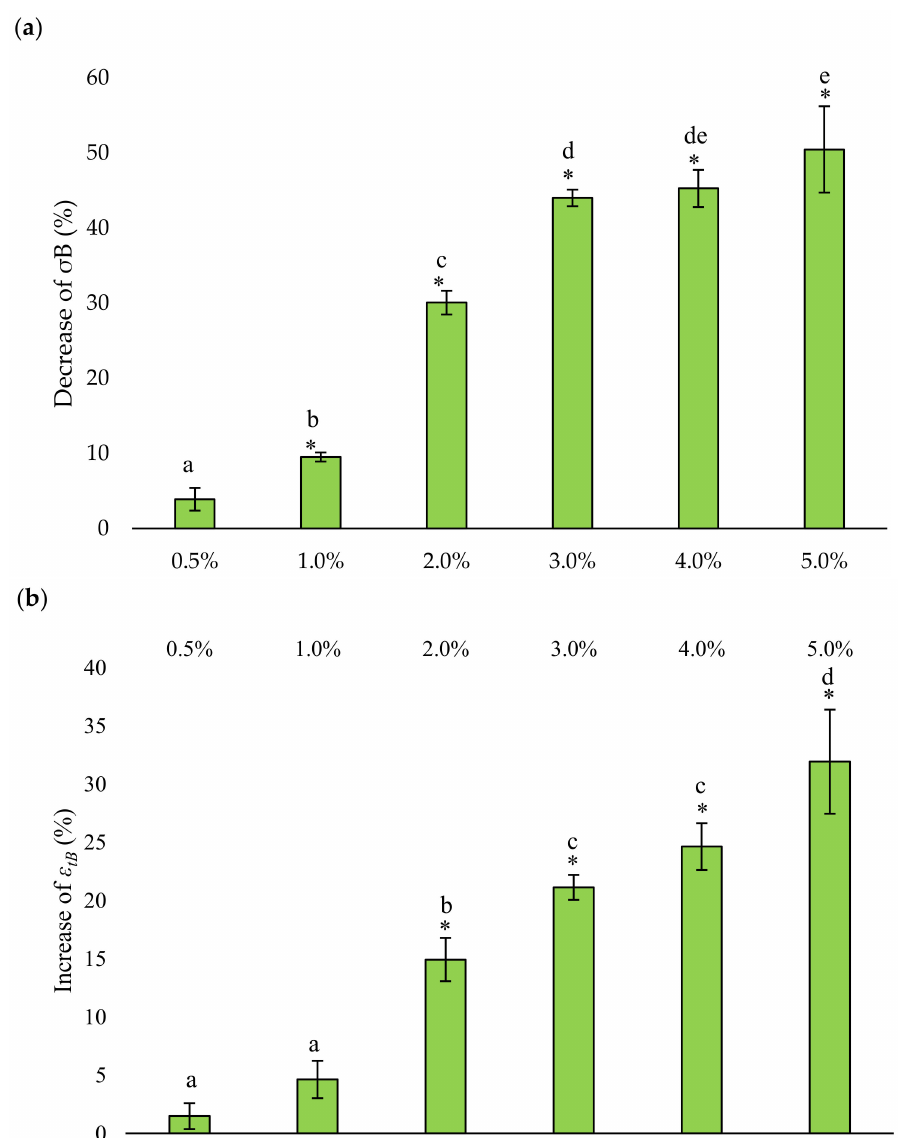
Figure 4. Strength properties for samples containing the biocide in a concentration from 0.5% to 5% (differences compared to the control samples without biocide): ( a ) tensile strength at break ( σ B ); ( b ) elongation at break ( ε tB ). Statistically significant differences from the controls are marked with an asterisk. Statistically significant differences between the variants are marked with separate letters. The values of ε tB ranged from 30.56% (for control samples without biocide) to